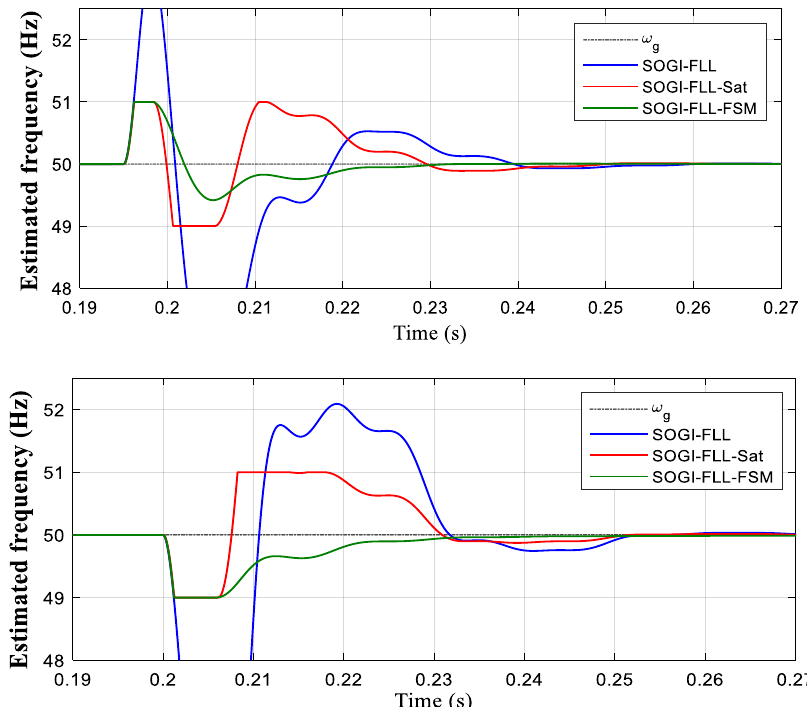
Figure 10. Transient responses to a 70% sag depth using the equations of Tables 2 and 3 to obtain 𝜉 and 𝜆 . In blue: SOGI-FLL. In red: SOGI-FLL with saturation. In green: FSM-based SOGI-FLL Upper: type-a sag. Lower: type-b sag.